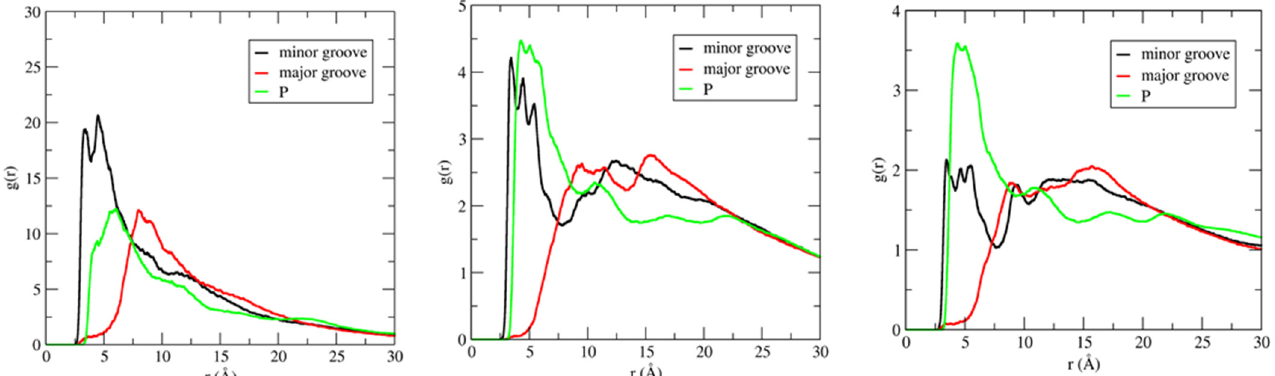
Figure 7. Center–of–mass (COM) radial distribution functions (RDF) for the [Im 16,1 ] + imidazolium ring around phosphate groups, minor, and major grooves of DNA duplex in different IL concentration solutions. RDFs calculations are performed using the N7 and O4 atoms for the electronegative sites in the major groove. Electronegative sites for the minor groove use N3 and O2 atoms. P atoms were used for the phosphate groups. IL concentrations are 20 mM ( left panel ), 250 mM ( middle panel ), and 500 mM ( right panel ).